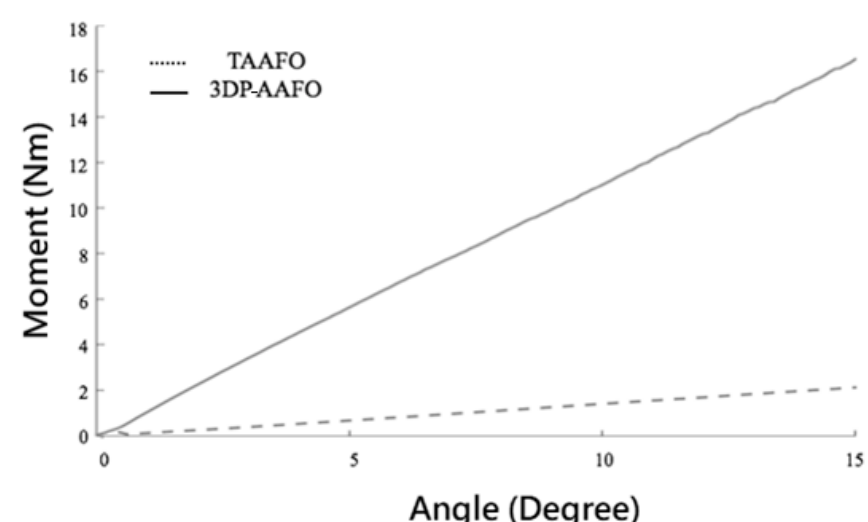
Figure 5. Comparison of stiffness in the TAAFO and 3DP-AAFOs.